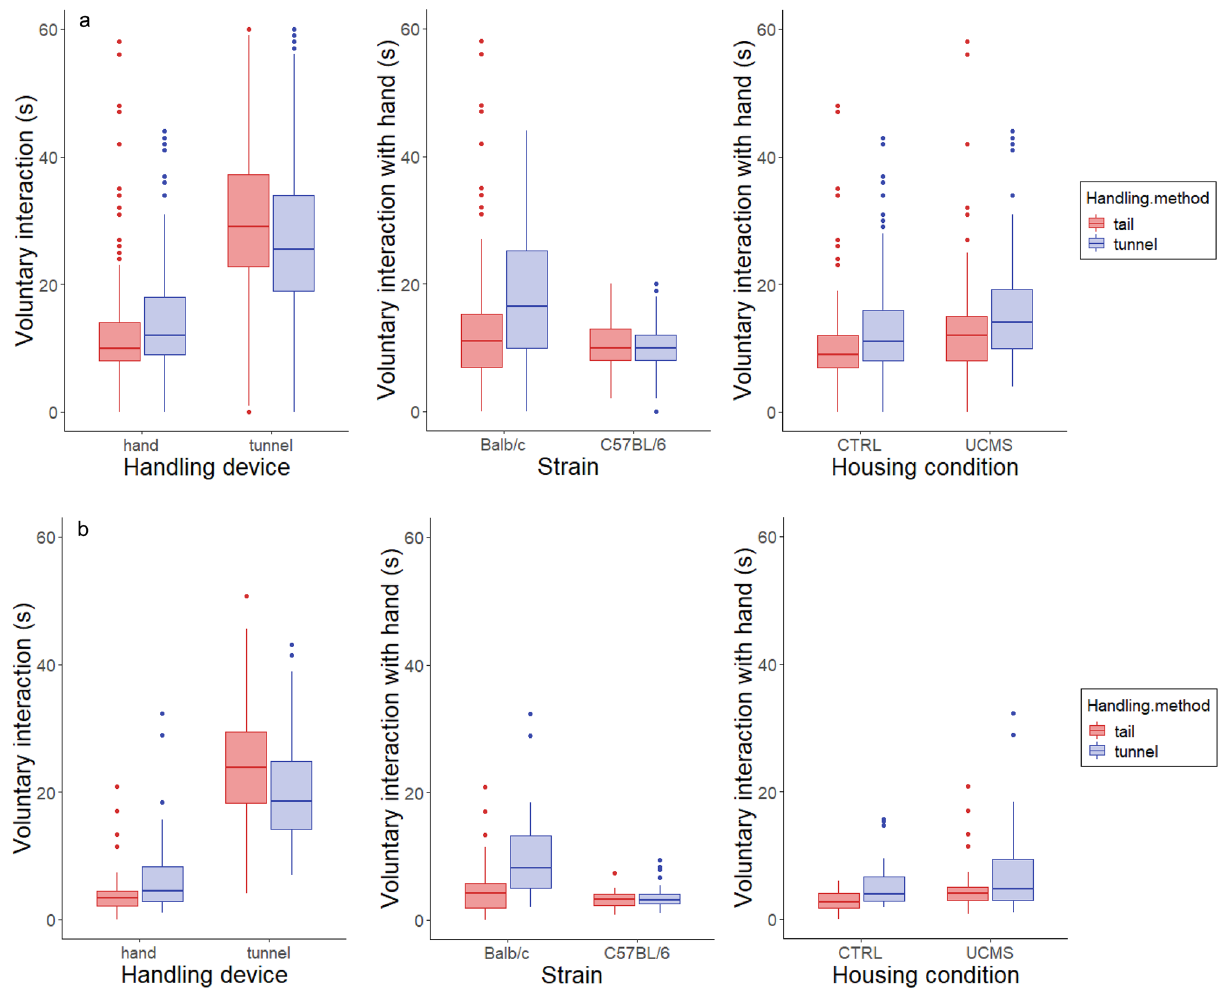
Figure 3. Voluntary interaction with both handling devices, experimenter’s hand and tunnel, when mice were briefly handled twice per week. ( a ) Voluntary interaction with the hand at weeks two and four of housing period and ( b ) after EPM testing. Both during housing and after EPM testing, mice interacted with the tunnel more than with the experimenter’s hand. Handling method affected voluntary interaction with the experimenter’s hand in Balb/c mice. UCMS housed mice also interacted with the experimenter slightly more than CTRL housed mice. Here, both interaction before and after handling are